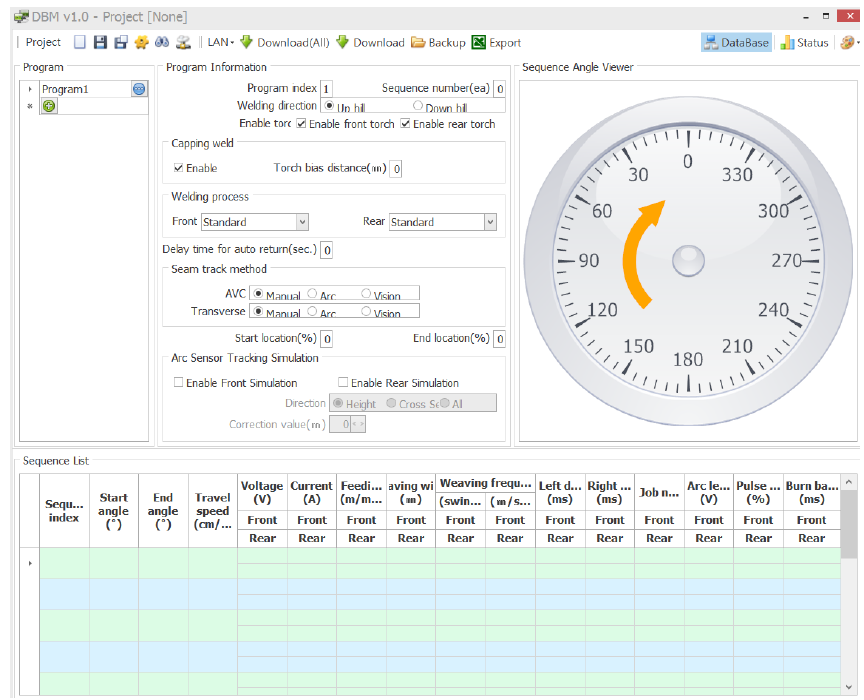
Figure 8. The user interface for welding settings using data base manager (DBM).